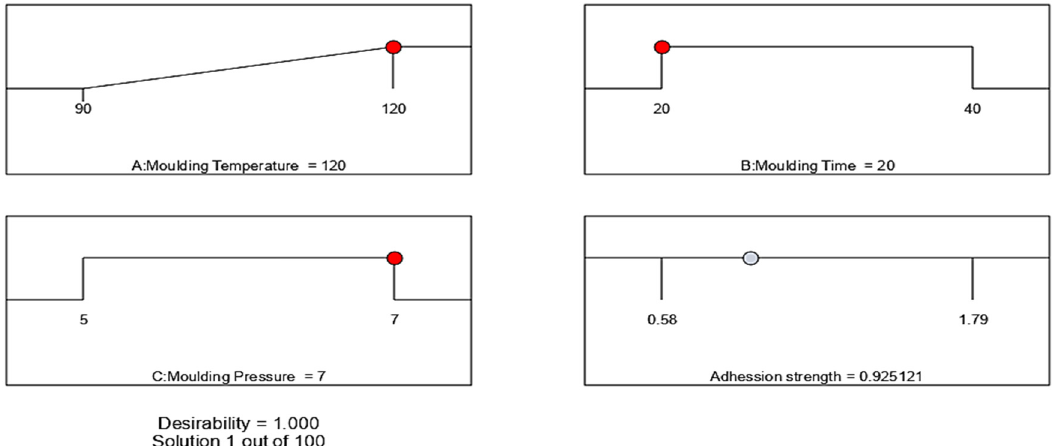
Figure 29: Ramp function graph for adhesion